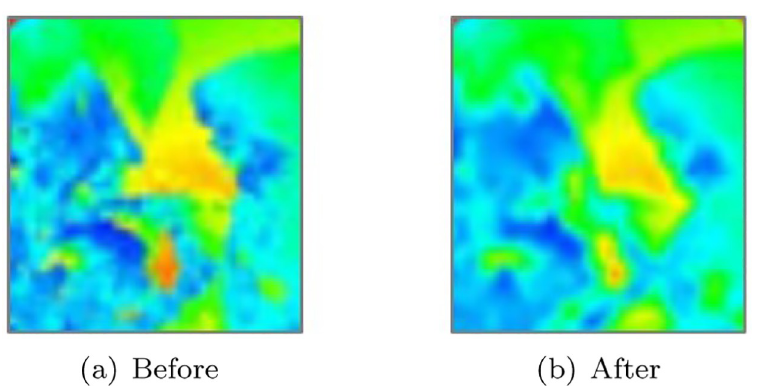
Fig 6. Comparison of aliasing artifacts. The pixels are colored according to the magnitude of d the blue (low). (a) Before, (b) After.